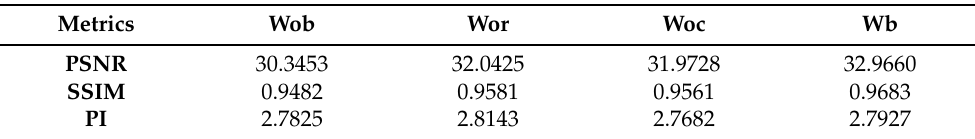
Table 6. Quantitative results with different loss functions on RESIDE dataset. ’wob’, ’wor’, ’woc’ and ’wb’ denote without both losses, without registration loss, without contrastive loss and with both losses, respectively.